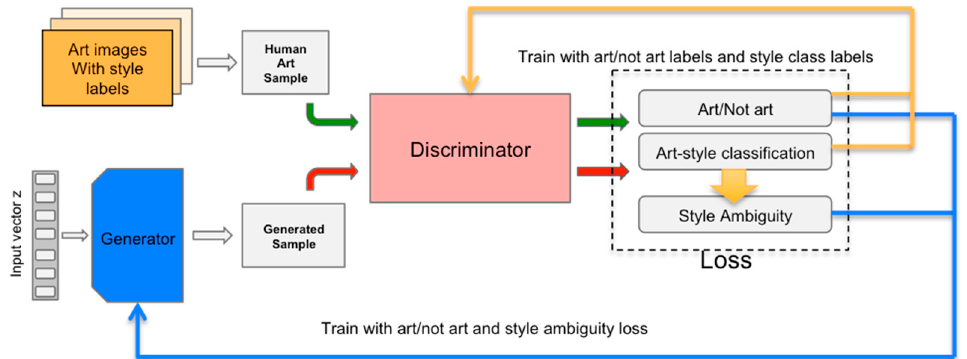
Figure 3. A block diagram of a creative adversarial network. The generator explores the creative space by trying to generate images that maximize style ambiguity while minimizing deviation from art distribution. Diagram by author A. Elgammal.